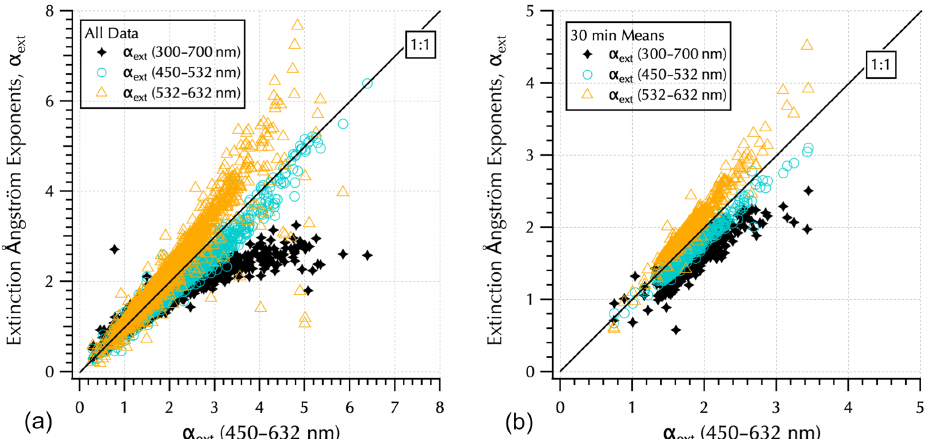
Figure 6. α ext determined over three different wavelength ranges (300–700nm, black diamonds; 450–532nm, teal circles; and 532–632nm, gold triangles) compared to that found over the 450–632nm range ( x axis). All data (a) and 30min means (b)